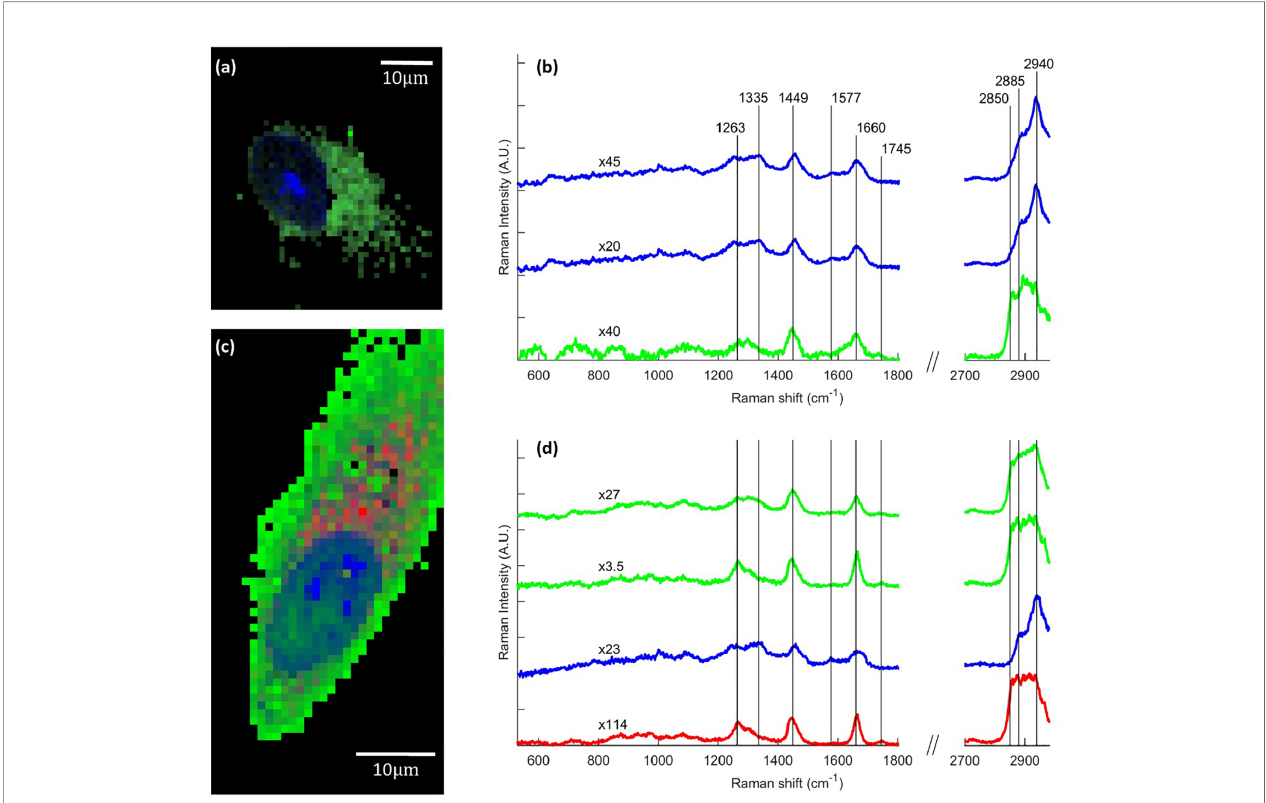
FIGURE 3 | Raman images of human mesenchymal stem cells (hMSCs), showing chemical variation due to falcarindiol (FaDOH) treatment. Representative examples of false color images and corresponding endmember Raman spectra for control cell (A, B) and 24 h FaDOH treated cell (C, D) produced using the spectral unmixing algorithm N-FINDR on the individual cell dataset. Endmember spectra are normalized (scale values indicated by x#) and truncated in the silent region (1,800 – 2,700 cm -1 ) for clarity. Each pixel in the images is represented by a combination of colours depending on the abundance value of an endmember. Blue, green and red endmembers contain bands associated with nucleus, cytoplasm and lipids respectively. Scale bars are 10